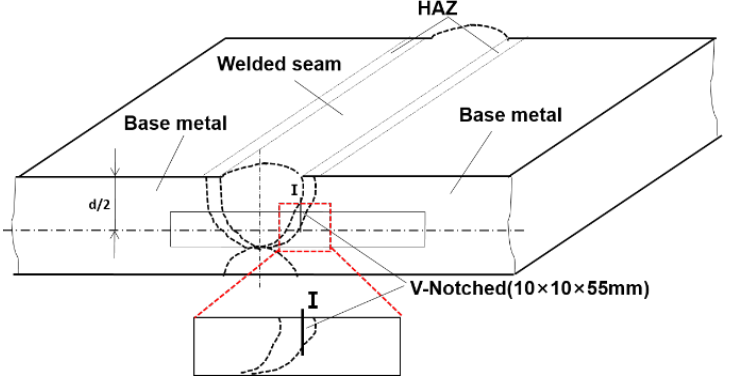
Figure 3. Position of micro-hardness measurement.